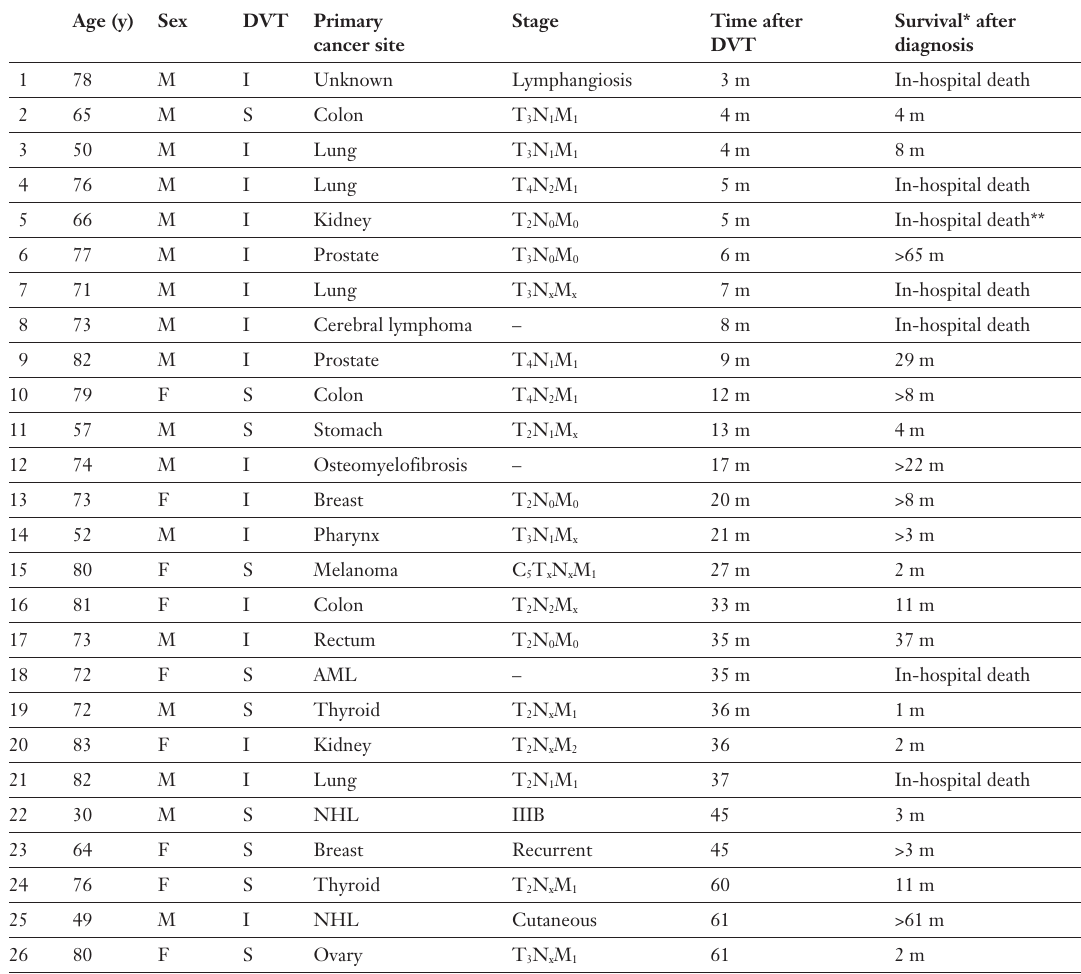
Incident cancers dur- ing follow up after an episode of idiopathic or secondary deep venous thrombosis.